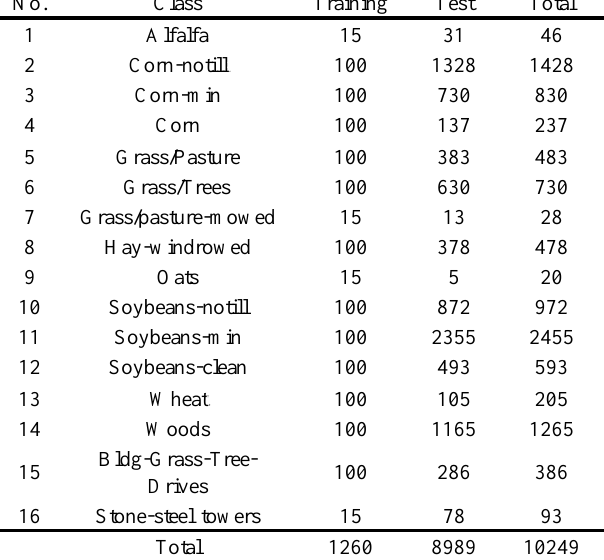
Table 1. The division of the dataset used by Indian Pines dataset.